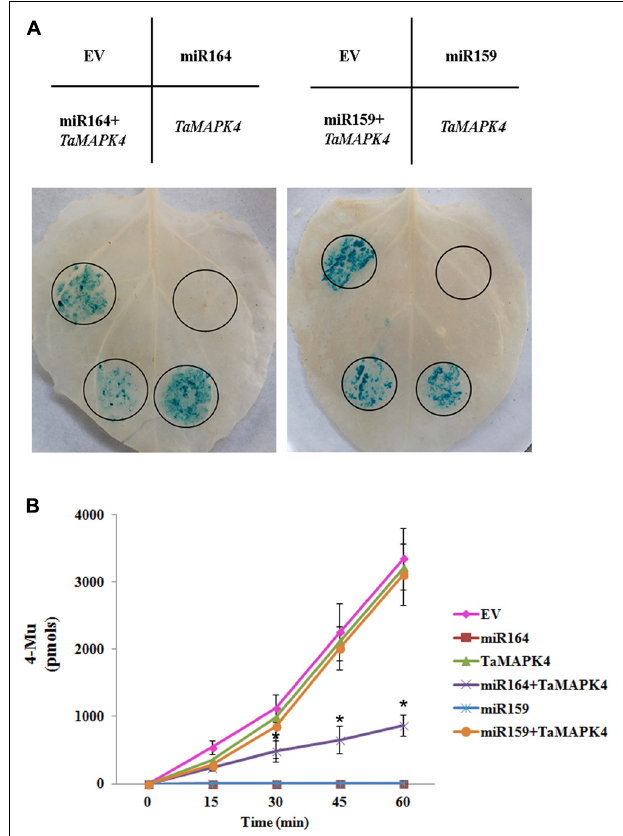
FIGURE 1 | Co-expression of tae-miR164 and TaMAPK4 in Nicotiana benthamiana leaves. (A) β -glucuronidase (GUS) phenotypes observed by histochemical staining. (B) Quantitative detection of GUS activity in leaves inoculated with different recombinant vectors at different time points using a fluorospectrophotometer. EV, empty vector; 4-MU, 4-methyl-umbelliferyl- β - D -glucuronide. The results are presented as the means ± standard errors of three biological replications. Significant differences were determined using Student’s t -test: ∗ P <